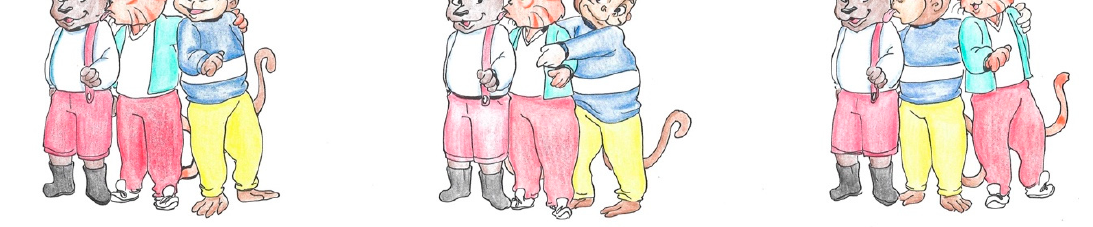
Figure A24. ORC stimulus 9.